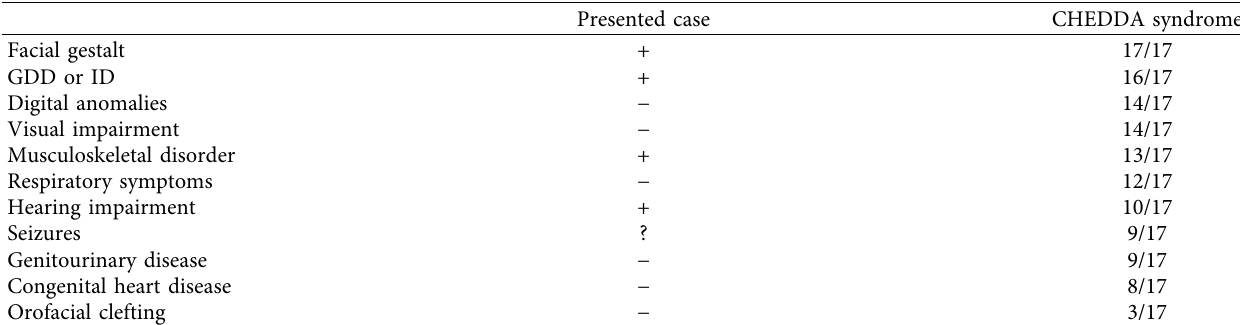
Congenital heart disease Orofacial